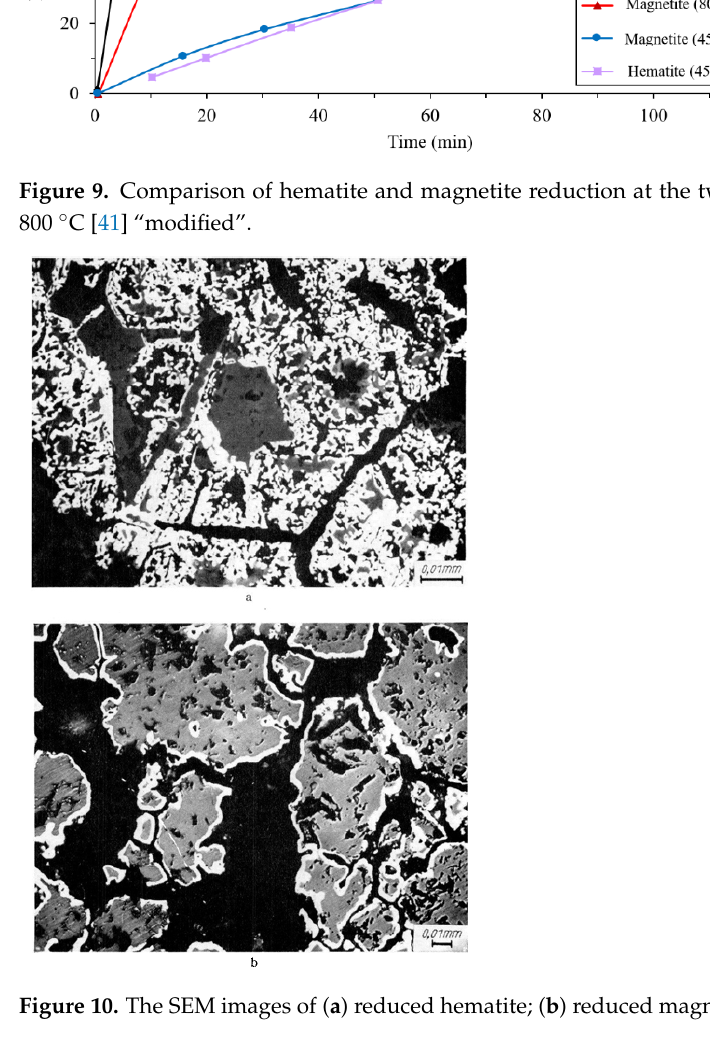
Figure 11. Reduction degree as a function of time for iron ore pellet, sinter, and lump ore at 700, 800, 900, and 1000 °C [44] “modified”. Fruehan et al. found that if iron oxides are converted to magnetite and kept in the same form as magnetite for a few minutes before reduction to iron, which can be called “annealing”, it causes a decrease in the degree of reduction especially at higher tempera- tures and lower hydrogen pressures (Figure 12) [28].